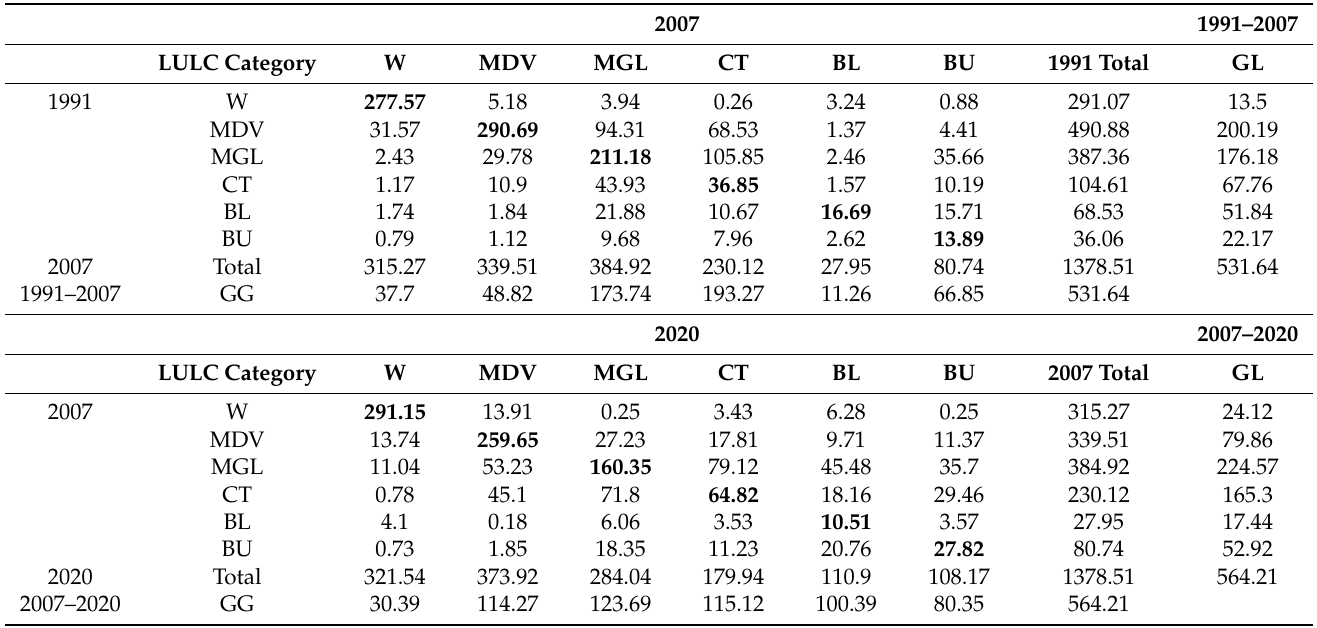
Figure 2. LULC maps of Keta Lagoon Complex Ramsar Site for ( a ) 1991, ( b ) 2007, and ( c ) 2020. Table 2. LULC change matrix in km 2 of the KLCRS landscape for the two time intervals (1991–2007 and